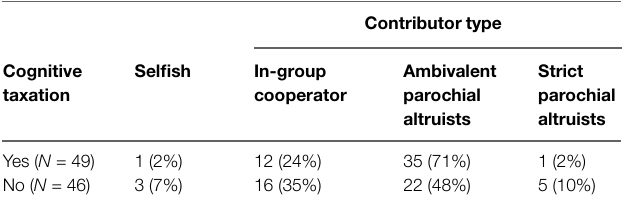
TABLE 1 | Contributor types broken down by cognitive